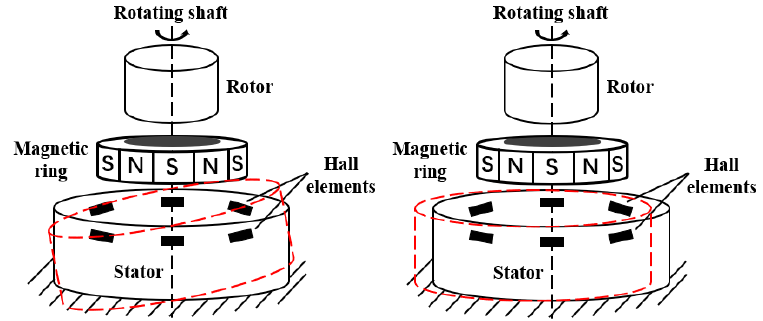
Figure 1. Tilt and eccentric error in manufacturing and installation.